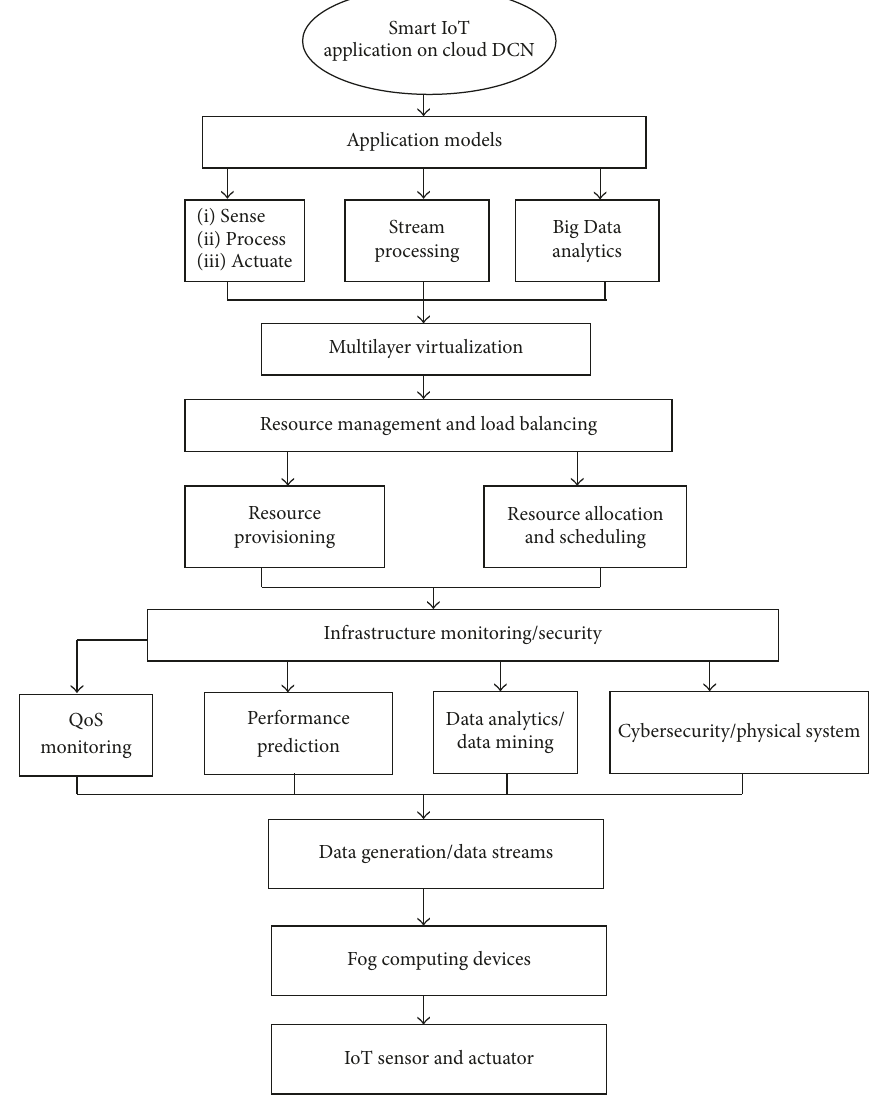
Figure 2: Fog computing IoT architecture for spine-leaf datacenter